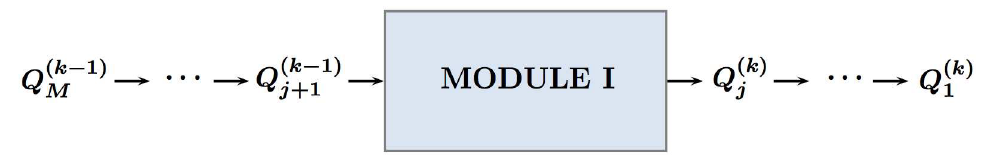
Fig 5. Pipelined Data Flow through MODULE